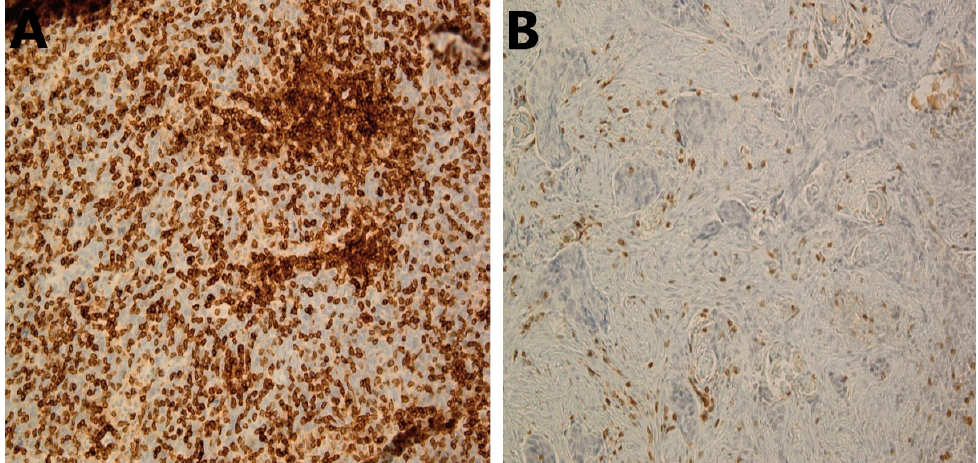
Figure 1. Immunohistochemical staining of CD3 + TILs in HNSCC. ( A ) High stromal CD3 + TILs in HNSCC tumor; 20×. ( B ) Low stromal CD3 + TILs in HNSCC tumor; 20×. HNSCC, head and neck squamous cell carcinoma; TILs, tumor-infiltrating lymphocytes.